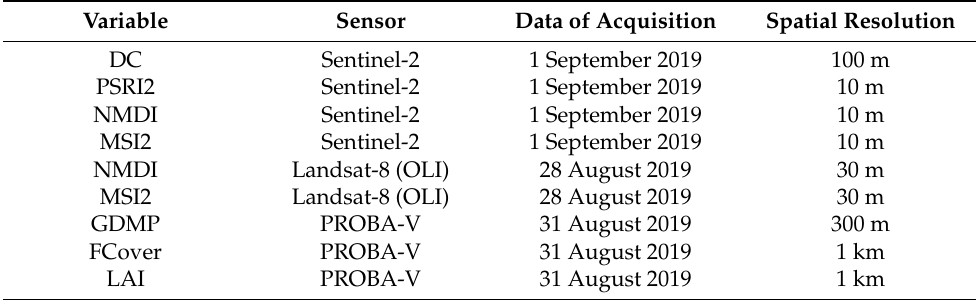
Table 3. Characteristics of the variables used in the final step of the validation process. Variable Sensor Data of Acquisition Spatial Resolution DC Sentinel-2 1 September 2019 100 m PSRI2 Sentinel-2 NMDI